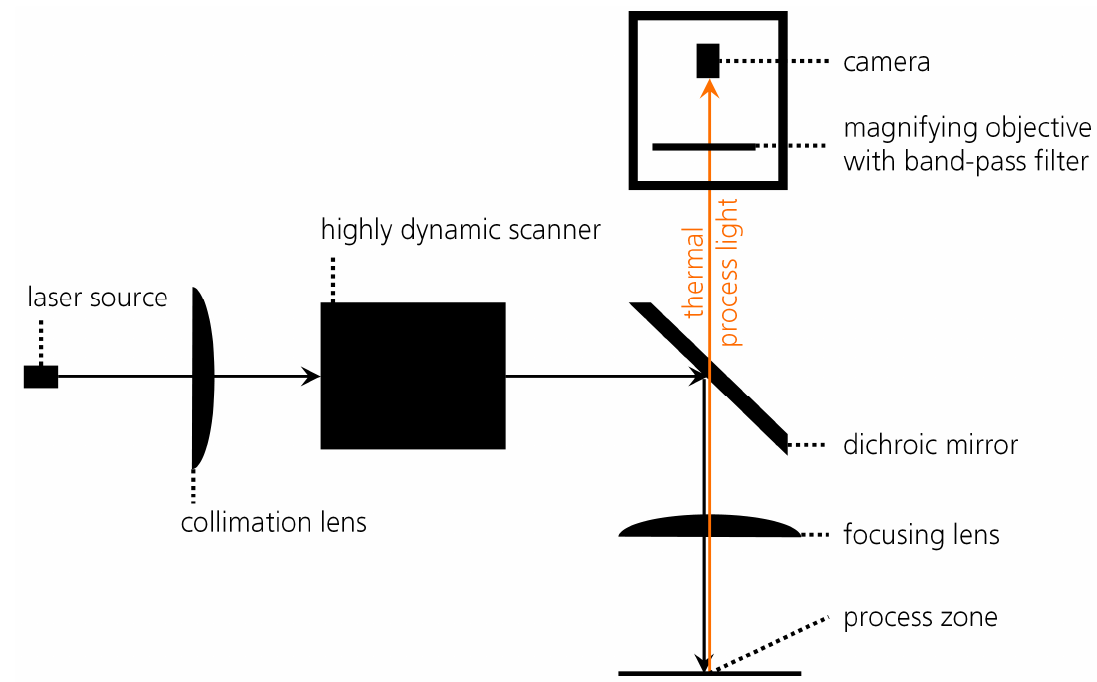
Figure 1. Schematic design of the experimental setup consisting of a standard cutting head with an integrated highly dynamic scanner to initiate beam oscillation and a camera unit for the high spatial and high frequency temporal resolution temperature measurement.